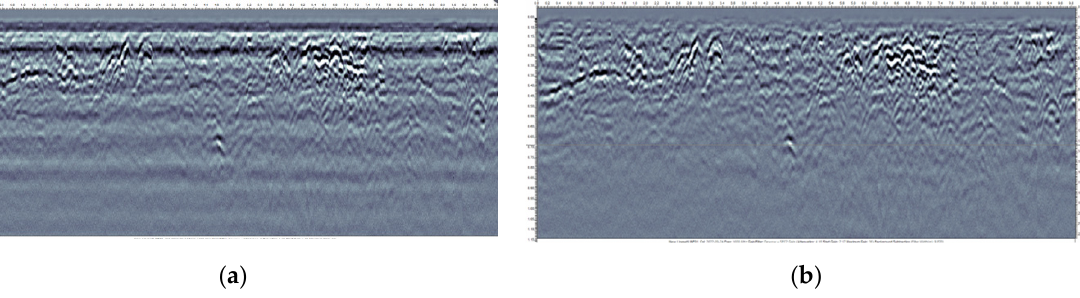
Figure 16. Image pre-processing: ( a ) before image pre-processing; ( b ) after image pre-processing. In the field test, a total of 70 root nodes were marked, among which there were 48 root nodes with root diameter above 1 cm. There were 42 hyperbolic waveform targets on B-scan images, and 37 hyperbolic waveform targets were successfully detected by the YOLOv5s detection model, with a detection rate of 88.09%. This indicates that the detection model based on YOLOv5s had a high detection rate for hyperbolic waveform in B-scan images detected in the field. From the results in Table 4, it can be seen that the maximum error of diameter estimation was 34.18% and the minimum error was 6.83%. The minimum and maximum distance between the predicted position of root positioning and the actual position were 0.67 cm and 8.73 cm, respectively. The error of root location and diameter estimation in the inner circle was larger than that in the outer circle. When the root diameter was small, the error of the root diameter estimation results was large, which is consistent with the test results on the simulation diagram, indicating that the method proposed in this paper had a certain feasibility in the field test. Table 4. Pre-buried root test results.